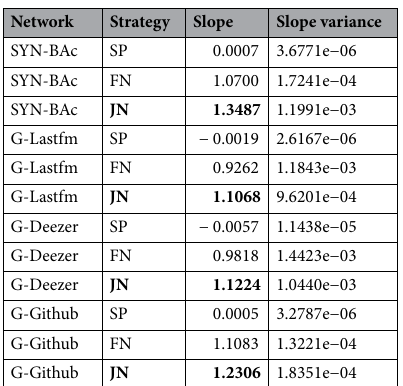
Table 1. Slopes of the normalized degree distributions for different networks and strategies.